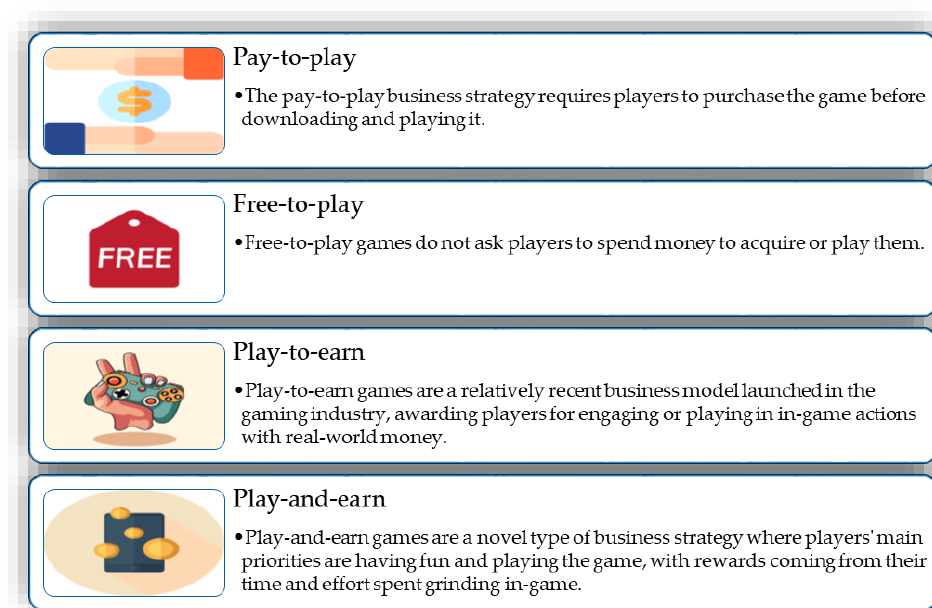
Figure 6. Various kinds of gaming business